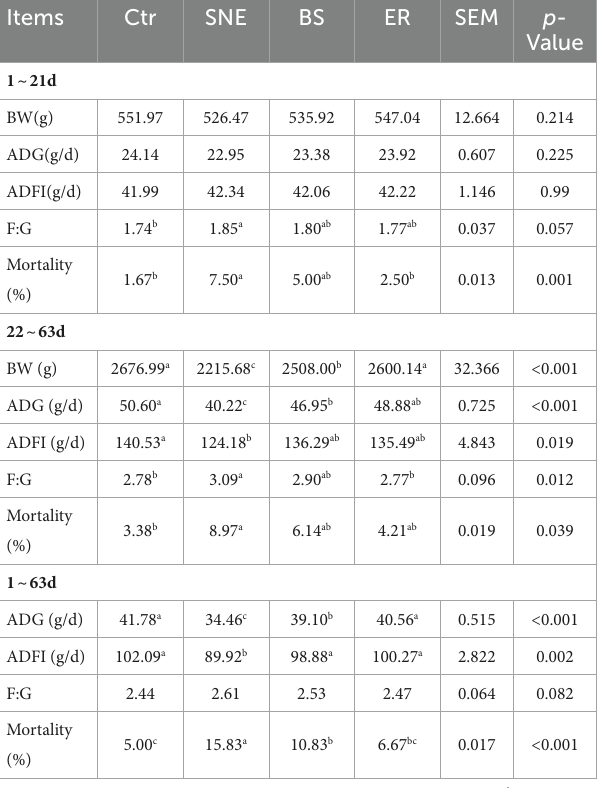
TABLE 3 Effects of Bacillus subtilis DSM29784 treatment group on the growth performance of broilers.